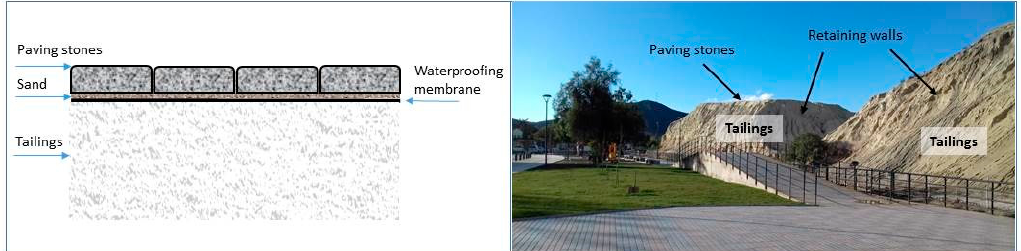
Figure 1. Scheme for using paving stones. The figure on the left shows a graphic. The figure on the right shows the proposed tailings surface coverage system at Andacollo